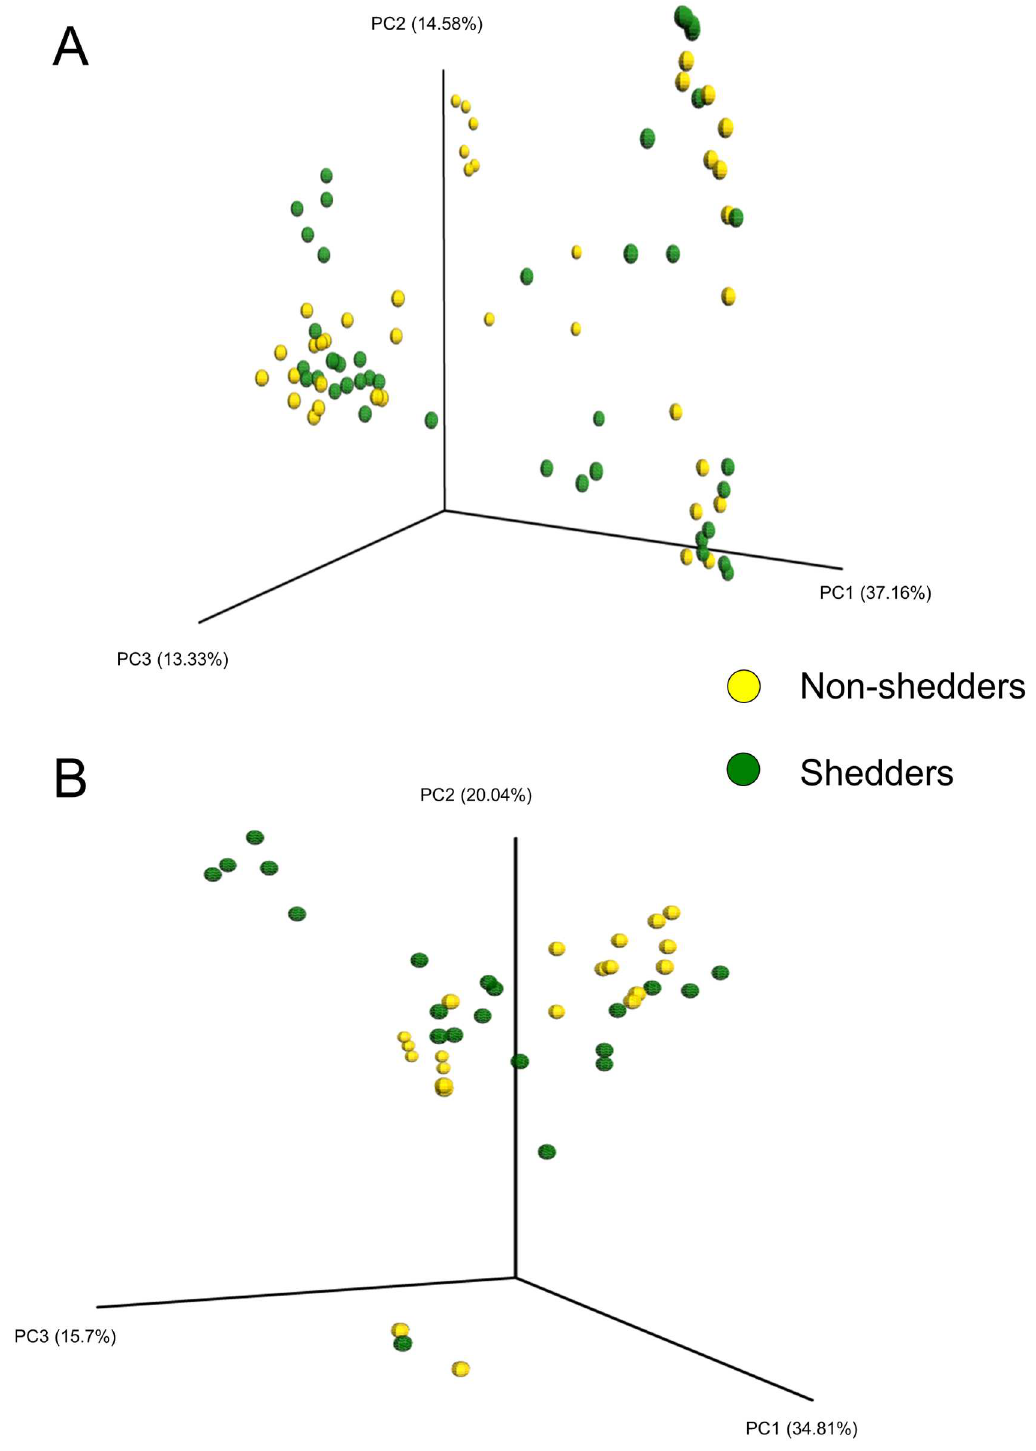
Fig 3. Principal coordinate analysis plots (PCoA) plots of the weighted UniFrac distances by E . coli O157:H7 shedding status. A) all samples and B) lower GI only. The percent variationexplainedby the principalcoordinates is indicatedon the